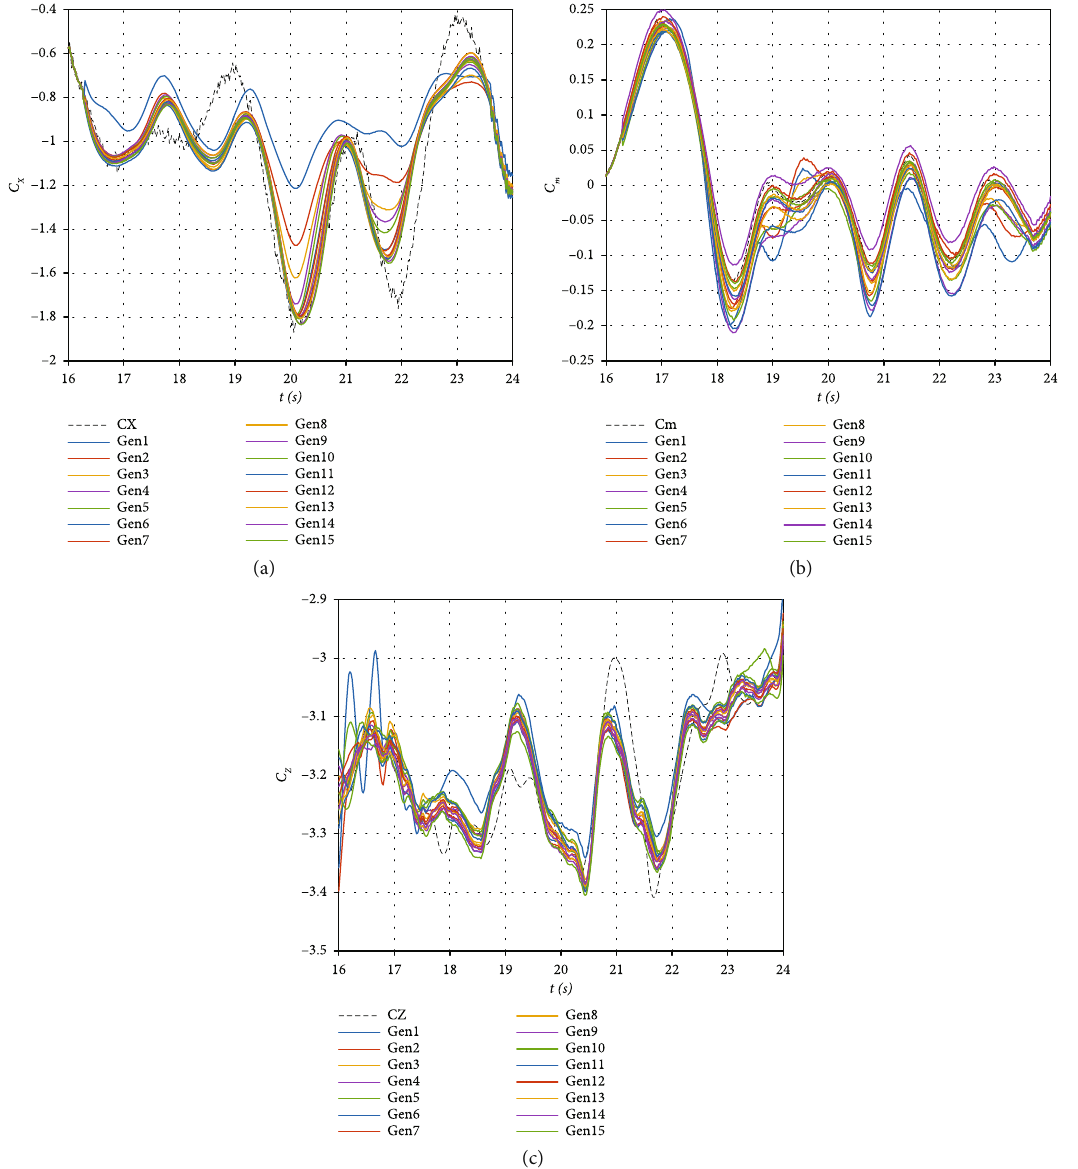
Figure 12: The CS results: (a) C